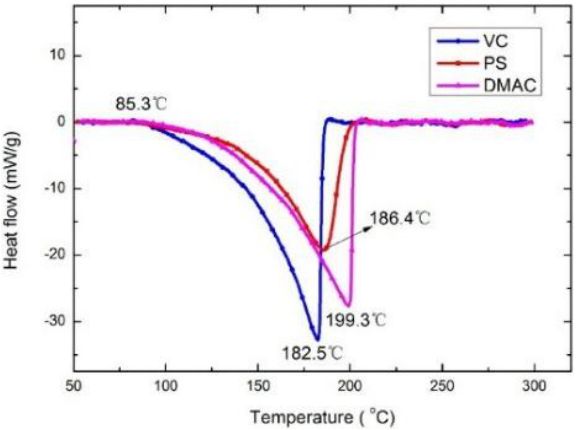
Figure 2. C80 Heat flow profiles of vinylene carbonate (VC), propylene sulfite (PS), and dimethylacetamide (DMAC) at a 0.2 °C/min heating rate.